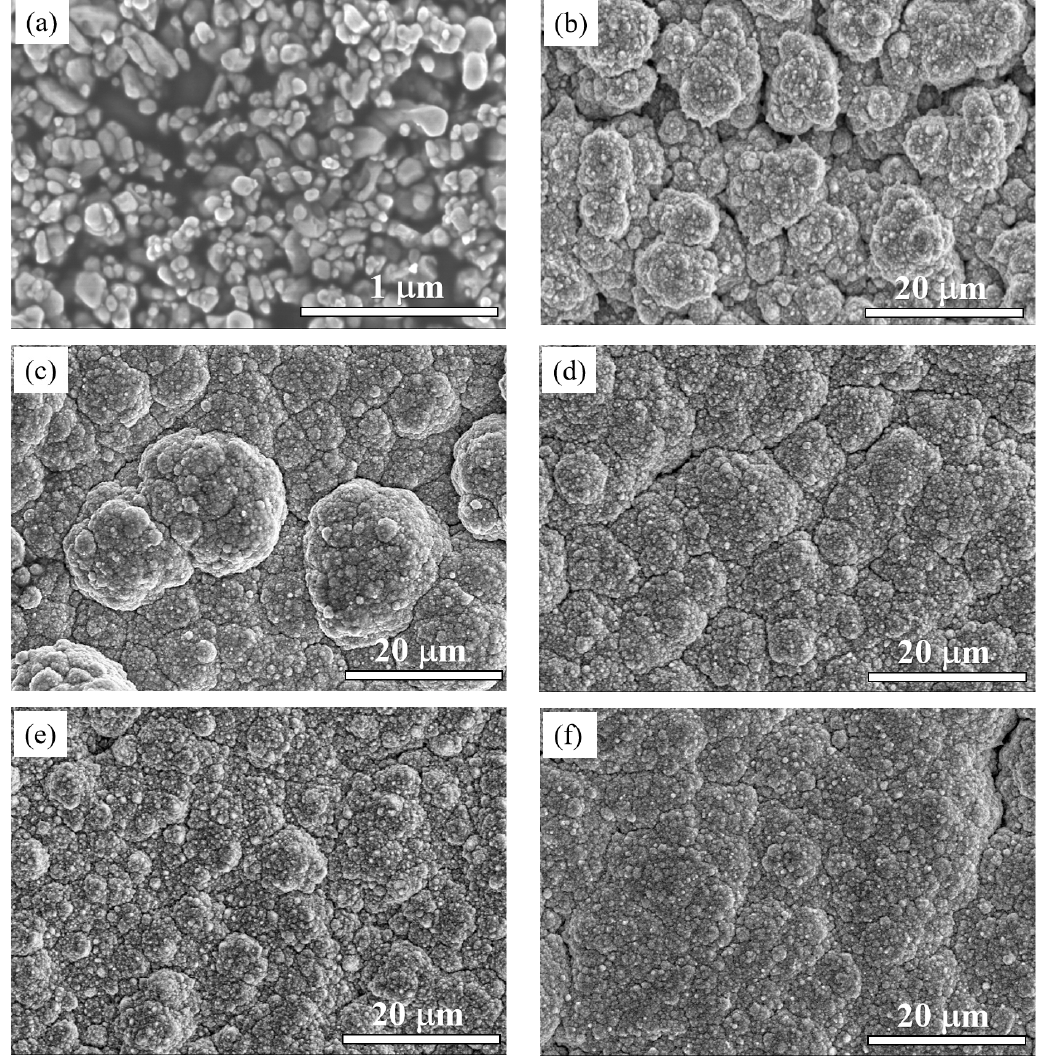
Figure 3. SEM images of Cu-Ni-ZnO nanocomposite coatings with different (Cu, Ni)-ZnO additions: ( a ) (Cu, Ni)-ZnO nanoparticles, ( b ) 0 g/L, ( c ) 2 g/L, ( d ) 4 g/L, ( e ) 6 g/L, and ( f ) 8 g/L.